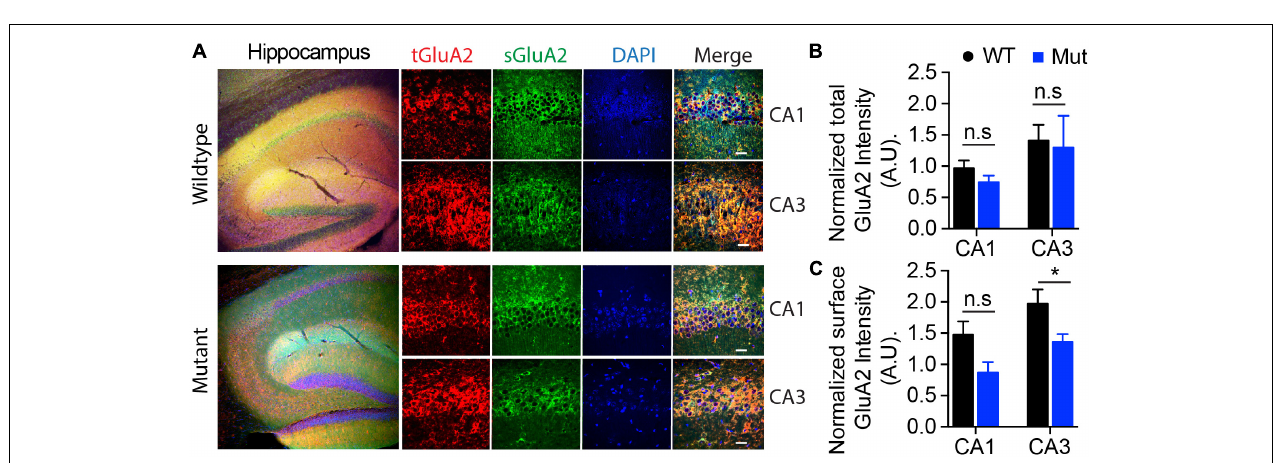
FIGURE 7 | Assessment of surface expression of AMPA receptor GluA2 in hippocampus by immunocytochemistry. (A) Representative images of immunohistochemistry of total (tGluA2) and surface (sGluA2) AMPA receptor GluA2 in wildtype and A350V IQSEC2 mutant hippocampi. Higher power representative images of the CA1 and CA3 regions are shown (right panel). Labeled scale bar for high-resolution images = 20 µ m. (B) Quantification of the normalized total GluA2 levels. Data represent mean ± SEM, n = 5 male mice in each group. No significant difference (n.s) P > 0.05, t -test, two-tailed. (C) Quantification of the normalized levels of surface GluA2 expression. Data represent mean ± SEM, n = 5 male mice in each group, ∗ p < 0.05, n.s. p > 0.05, t -test, two-tailed.